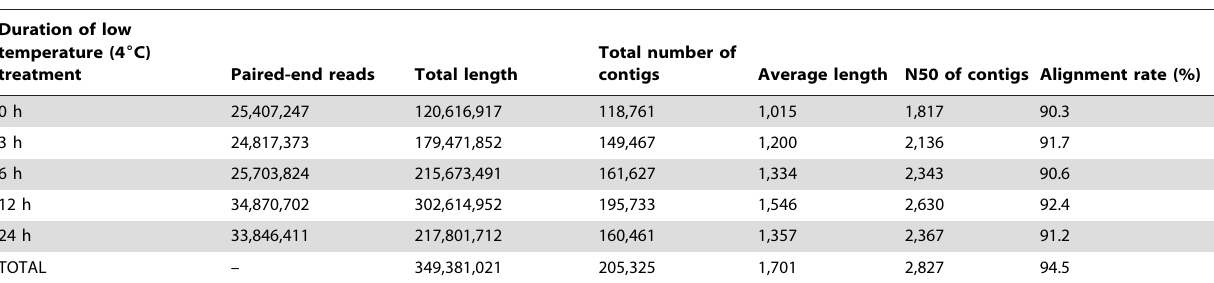
Table 1. Total number of reads for each treatment sample, as obtained by Illumina sequencing.